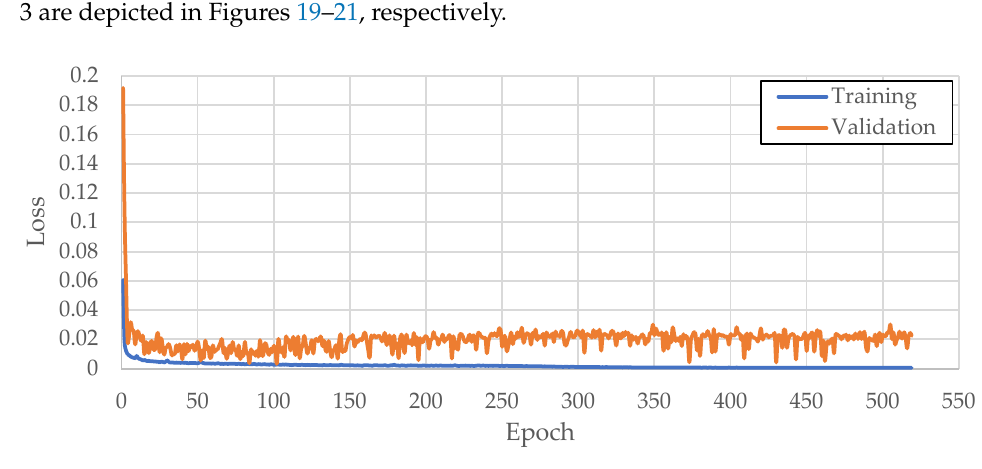
Figure 19. Training and validation losses produced in Model 1 over 518 epochs.